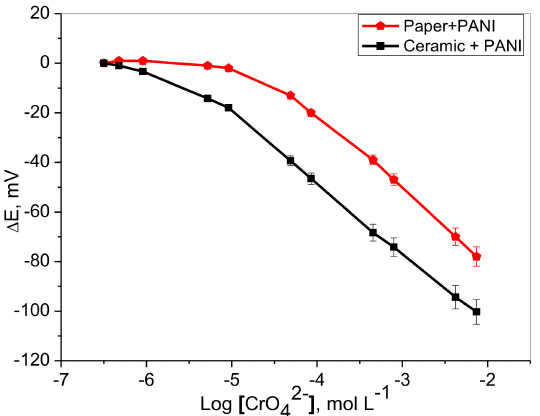
Figure 2. Calibration plots of paper and ceramic based chromium(VI) sensors with PANI solid contact in 5.0 mmol L − 1 Trizma bu ff er of pH ~8.